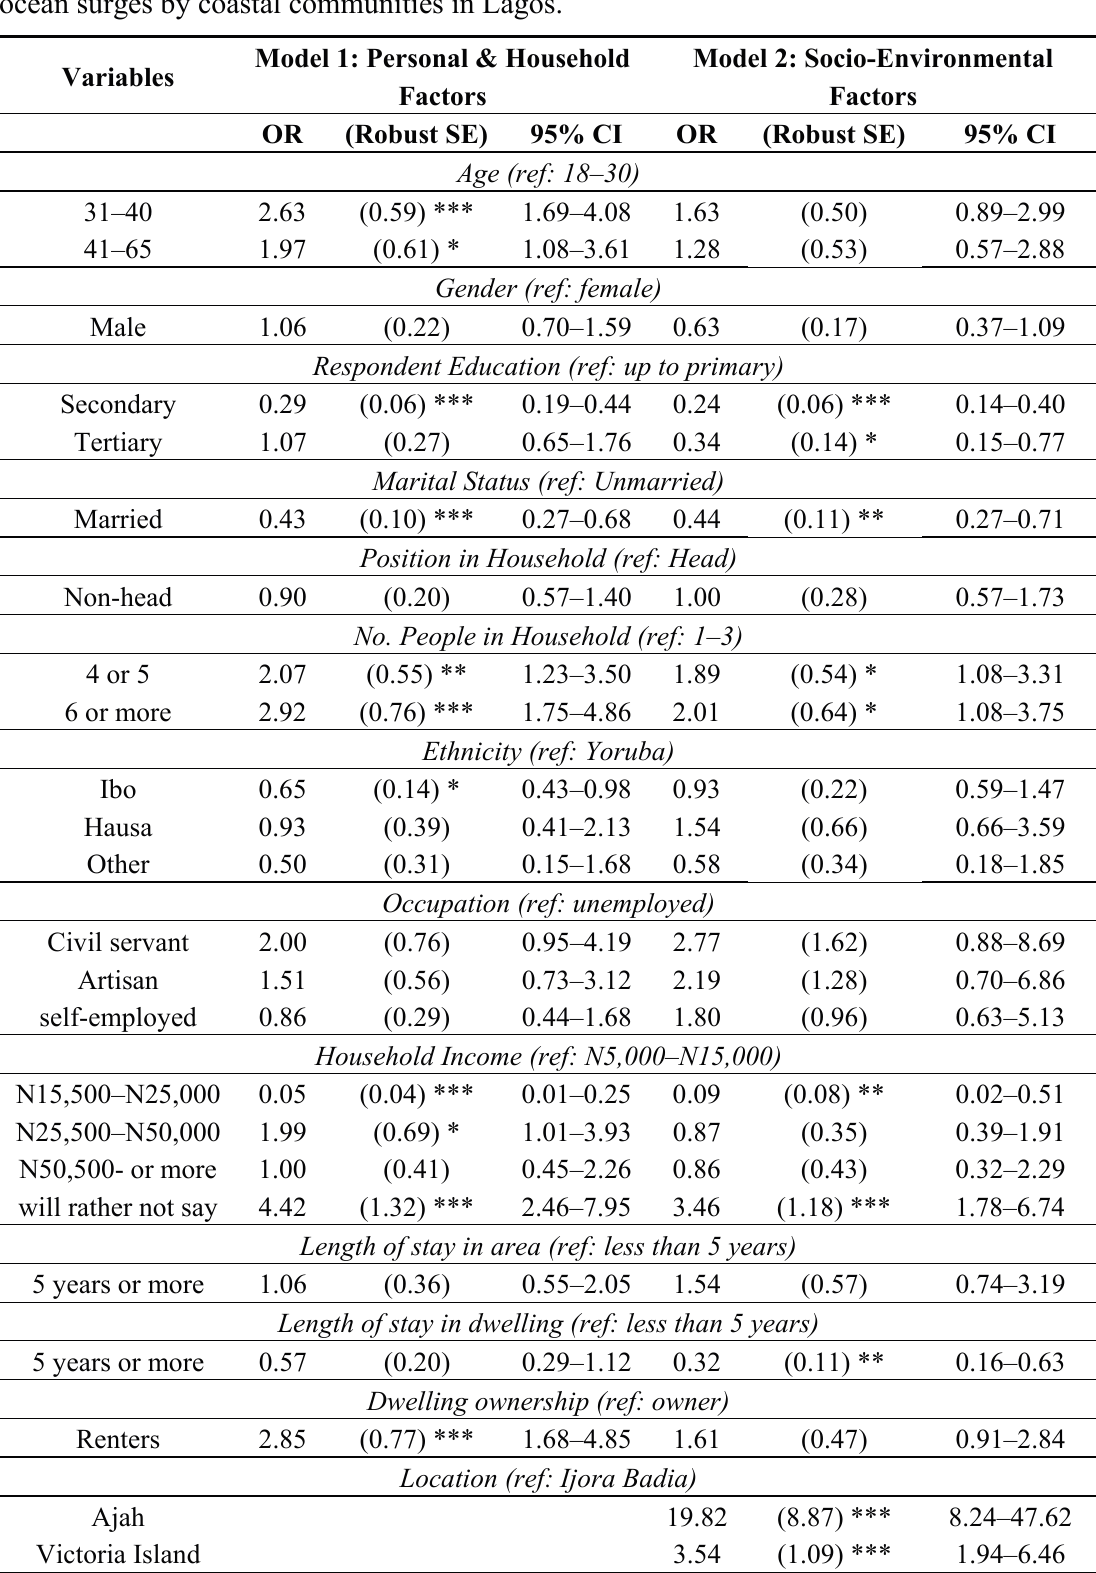
Table 3. Multivariate complementary log-log regression model predicting the experience of ocean surges by coastal communities in